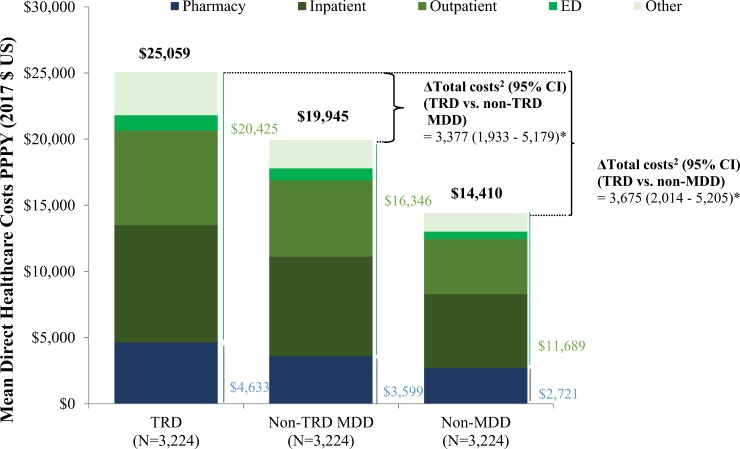
All-cause healthcare costs per-patient-per-yeara during the follow-up period (main analysis).Abbreviations: CI = confidence interval; ED = emergency department; MDD = major depressive disorder; PPPY = per patient per year; TRD = treatment-resistant depression. Notes: *: significant at the 5% level. [1] Healthcare costs measured from the index date up to 2 years post-index date. [2] Adjusted for baseline total healthcare costs and Quan-CCI.